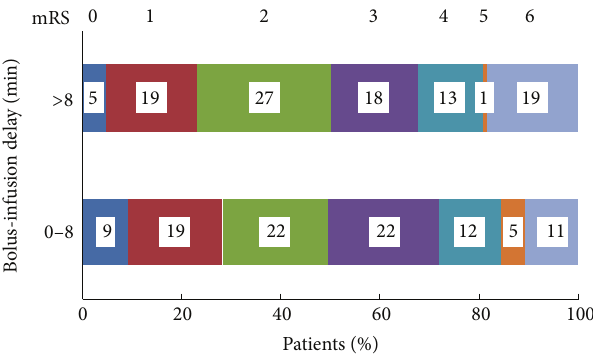
Figure 1: Bolus-infusion delays during treatment with intravenous alteplase within 4.5 h and outcome at 3 months after stroke. mRS- modified Rankin